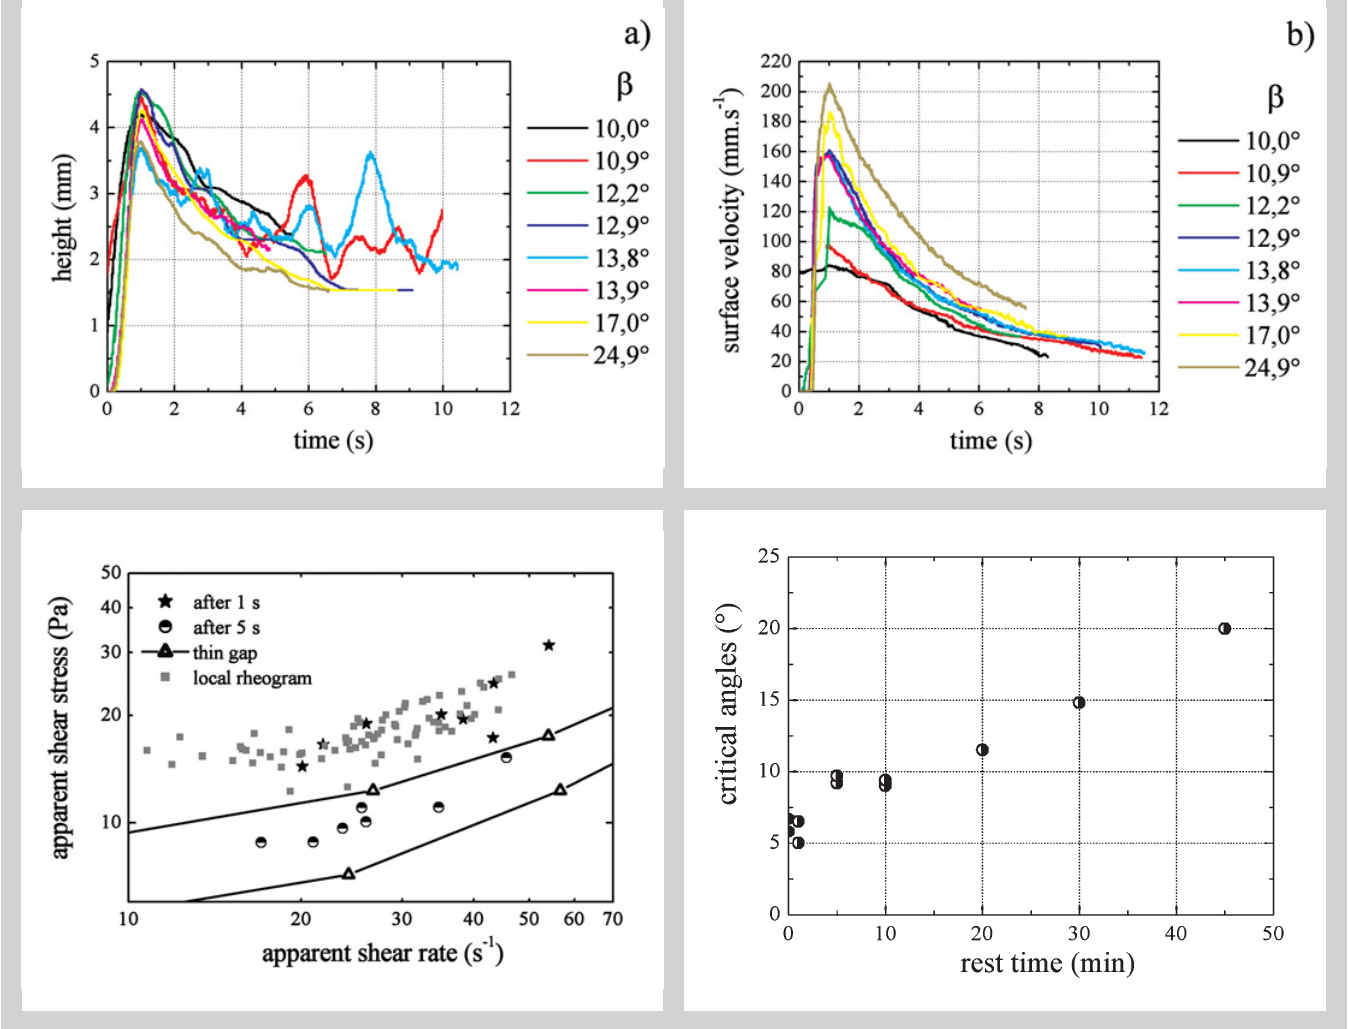
Figure 8 (above): Measurements for a 30 s rest time and different slope angles: a) thickness, b) surface velocity. Figure 9 (left below): Apparent rheograms as determined from inclined plane measurements for 30 s rest time and after 1 and 5 s of flow. Comparison with the thin gap Couette geometry rheogram and the rheogram obtained from local MRI measurements. Figure 10 (right below): Critical angles as a function of the time of